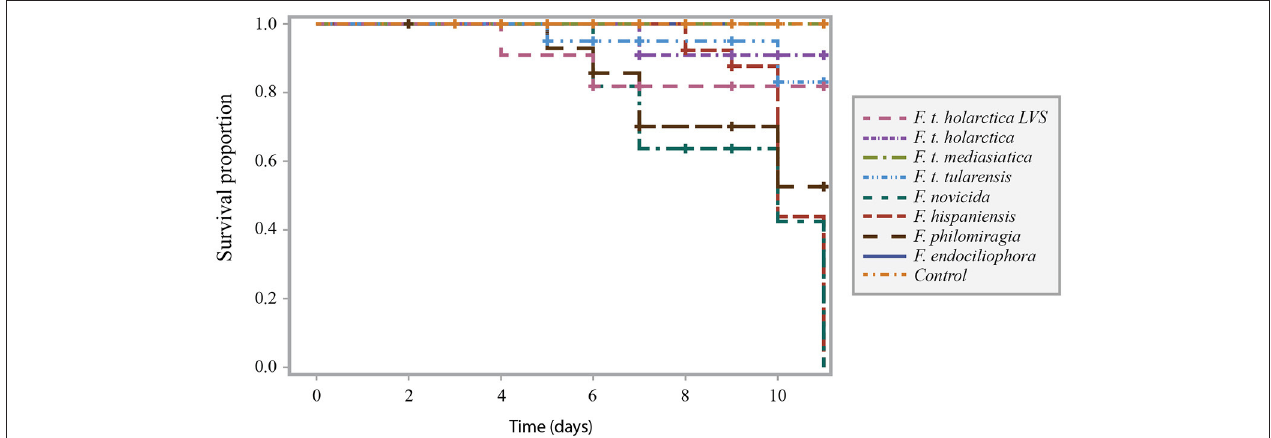
FIGURE 2 | Survival curve comparison of G. mellonella infected with F. t. tularensis, F. t. holarctica, F. t. mediasiatica, F. novicida, F. hispaniensis, F. philomiragia , and F. endociliophora at a temperature of 22 ◦ C with an infectious dose of 10 6 bacteria/mL. Experiments were performed in three separate runs with ten larvae in each run for each treatment. Censored observations are indicated with a plus sign ( +